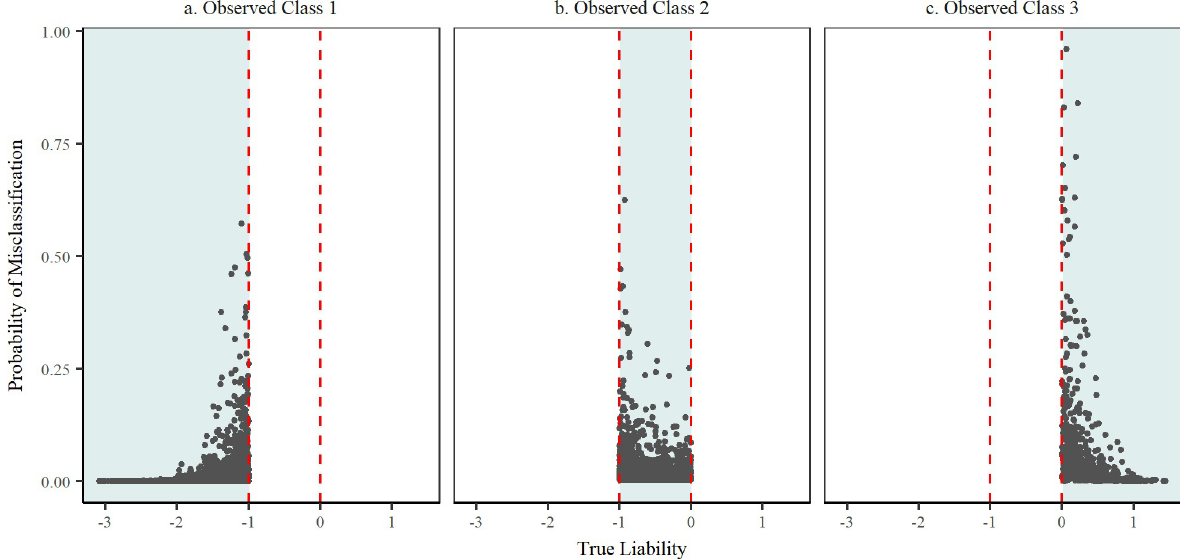
Fig 2. Probability of misclassification of correctly classified observations. Dashed red lines indicate the threshold values separating the three categories.